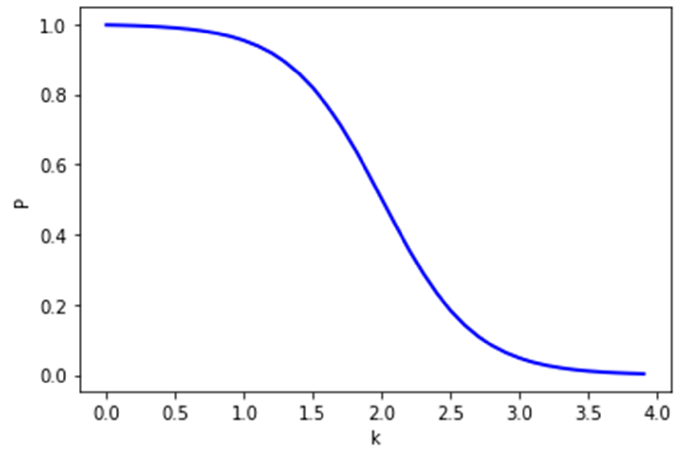
Figure 12. Probability of reservation to be accepted.